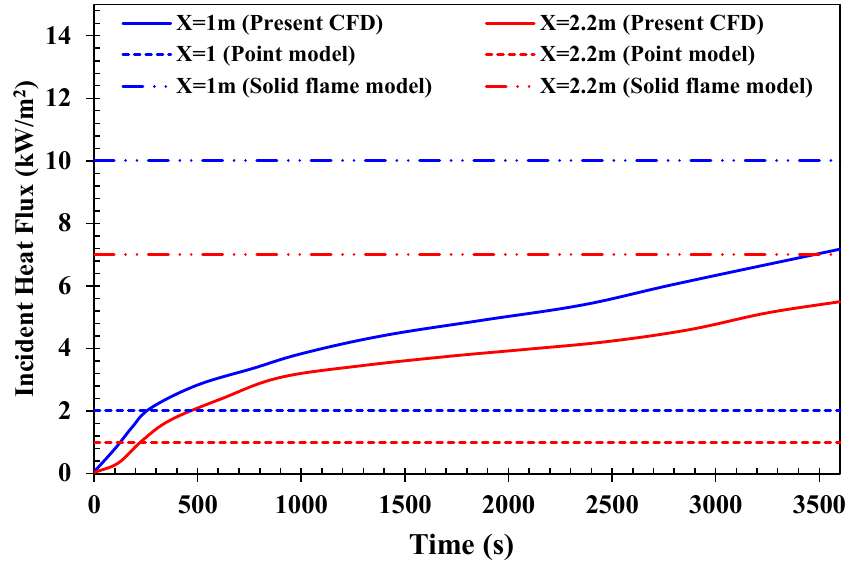
Figure 9. Incident heat flux on the outer layer of mild steel